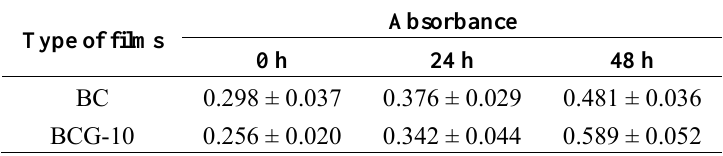
Table 1. Cell viability results from MTT assay of Vero cells on BC (control) and BCG-10